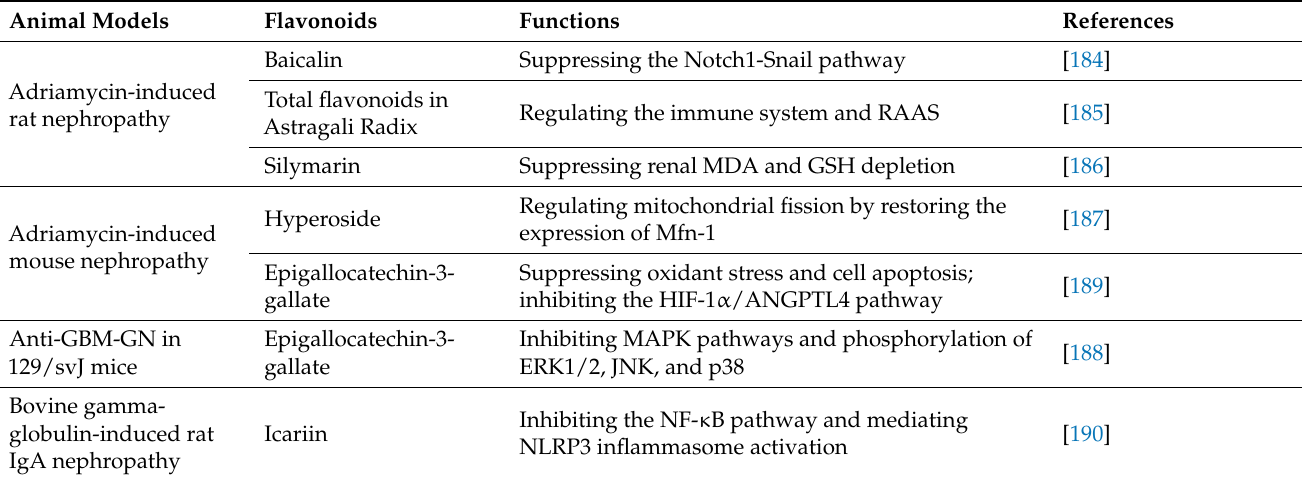
Table 4. Flavonoids in